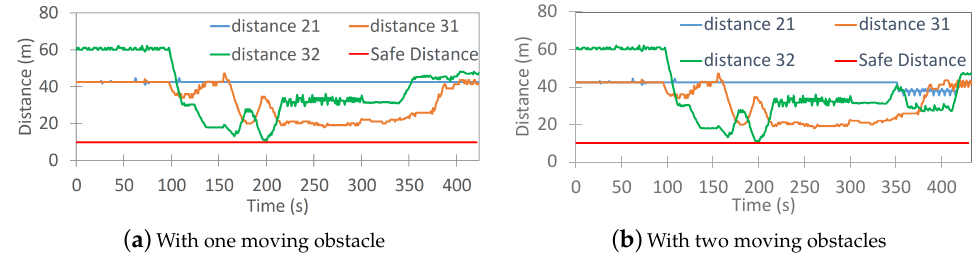
Figure 6. The results shown from the simulations of two case scenarios showing the traces of move- ment and deviations due to moving obstacles, with one moving obstacle and two moving obstacles. ( a ) Mission start. ( b ) Moving obstacle observed. ( c ) Overall trace of movement. ( d ) Mission start. ( e ) Movement of Obstacle 1 observed. ( f ) Movement obstacle 2 observed and traces of the deviated path.